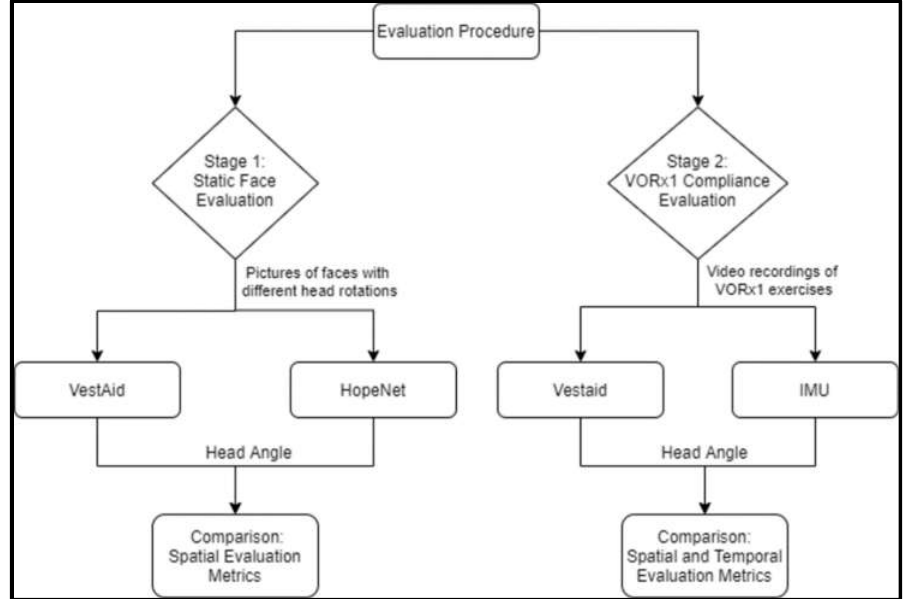
Figure 14. Overview of two-stage evaluation procedure.